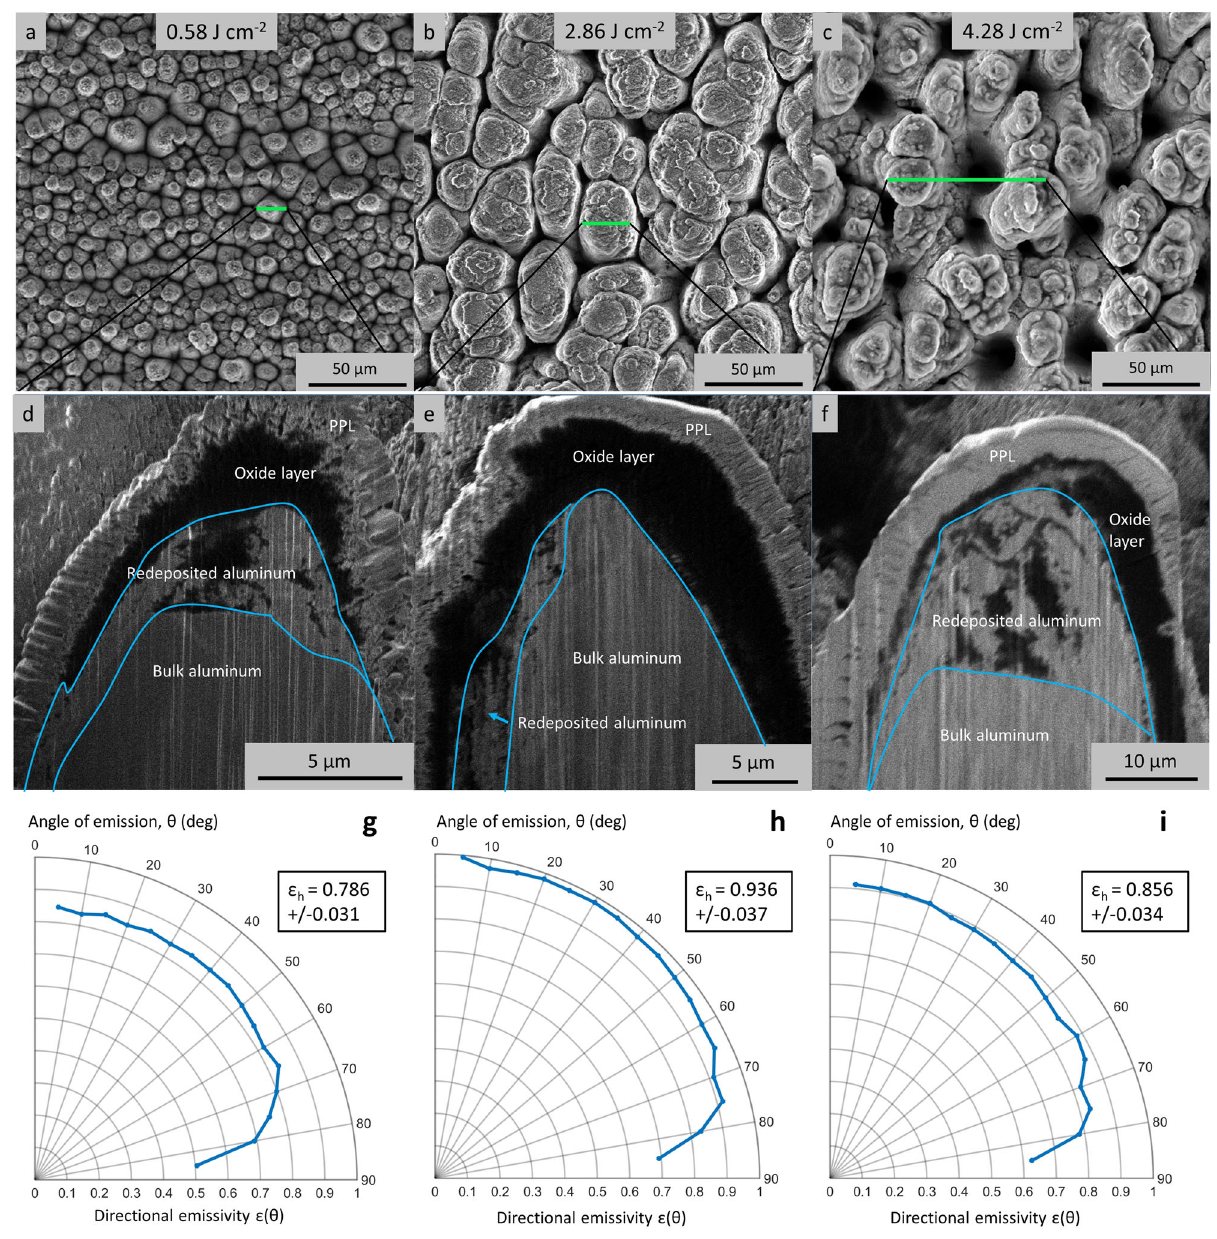
Fig. 3 Surface and subsurface images, and emissivity of samples produced in air environment. a – c SEM images of samples produced at the fl uence speci fi ed in the gray box in the top middle of each image for a constant pulse count of 1865. d – f Ion beam images of FIB Cross-Sectioned mounds to show subsurface structure of the corresponding sample in a – c . The green lines in a – c indicate the location of the corresponding cross section in d – f . PPL stands for protective platinum layer that is deposited before the cross-sectioning. Blue lines are included to better distinguish the transition between layers with different microstructure or material composition. g – i The corresponding directional and hemispherical emissivity of each sample in the same